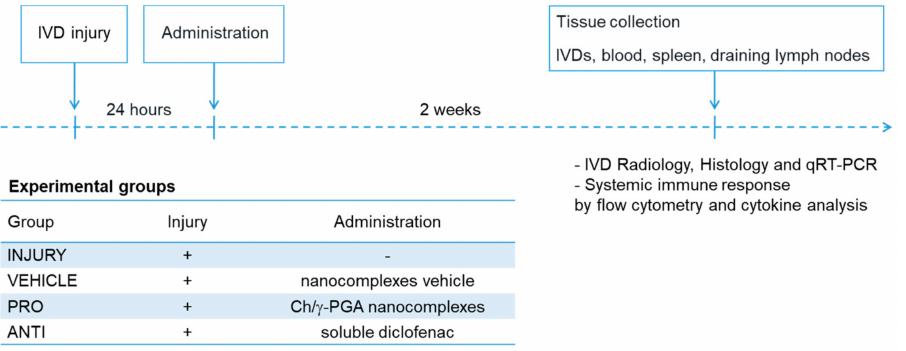
Figure 1. Experimental